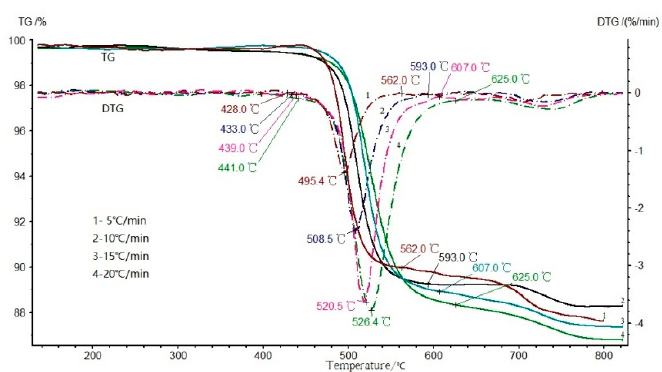
Figure 3. TG/DTG curves of high ‐ sulfur bauxite at different heating rates.